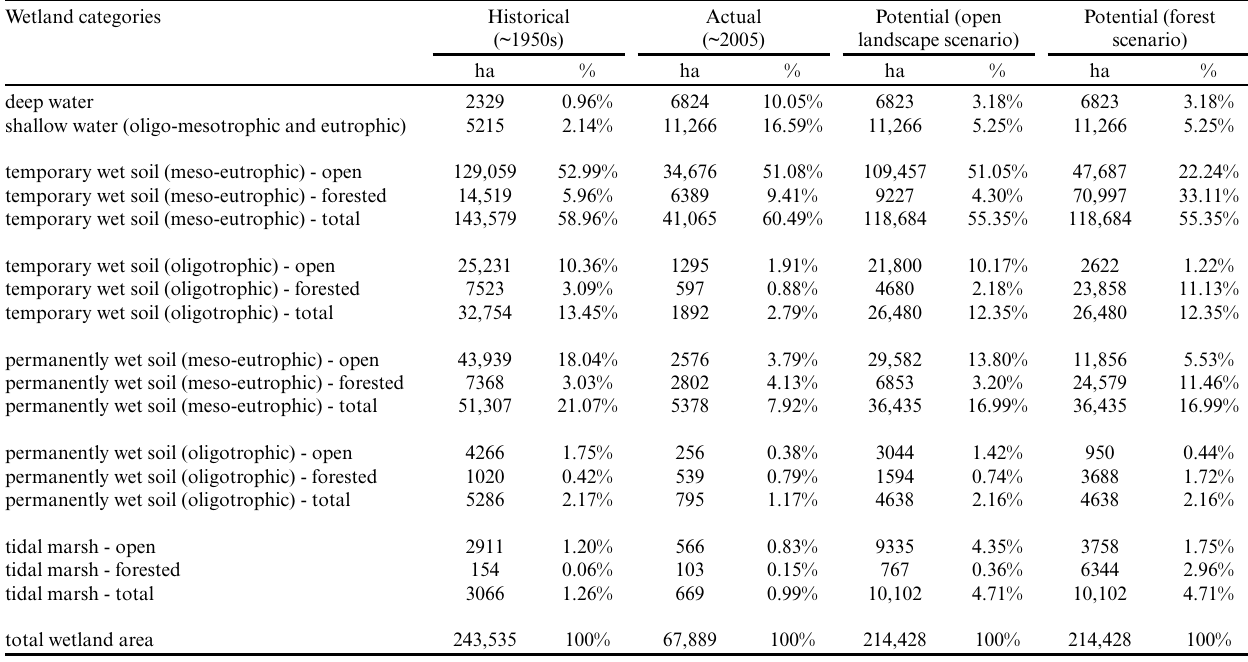
Table 3 . Estimations of the historical (± 1950s), actual (± 2005) and potential presence of seven wetland categories in Flanders (in ha). For the theoretically restorable wetlands, distinction is made between a forested and open landscape scenario. Potentials for deep and open waters were not